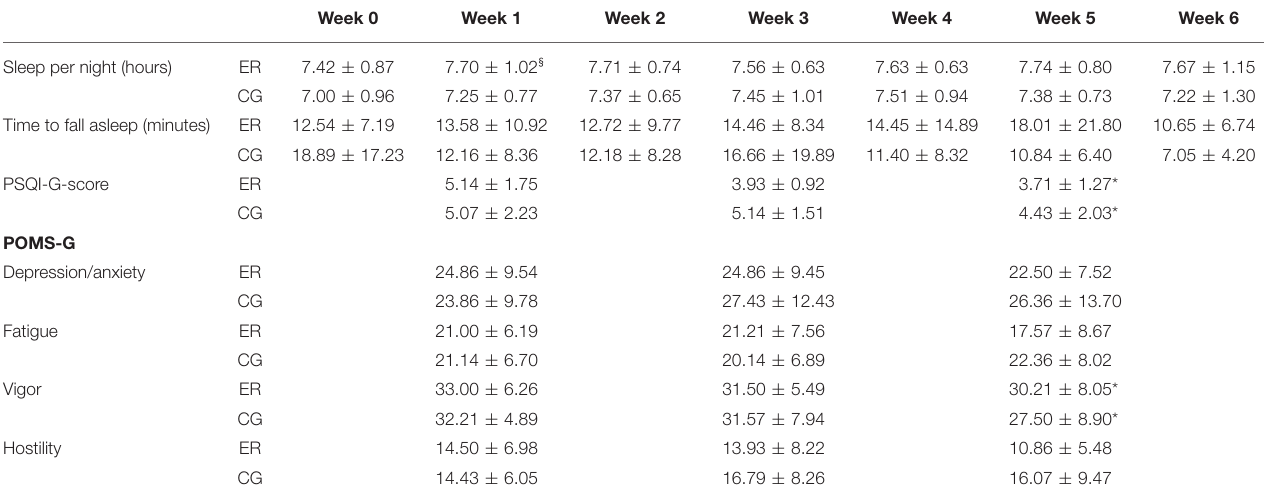
TABLE 5 | Overview of the sleep and mood analysis [energy-restricted group (ER), control group (CG), PSQI-G (Pittsburgh sleep quality